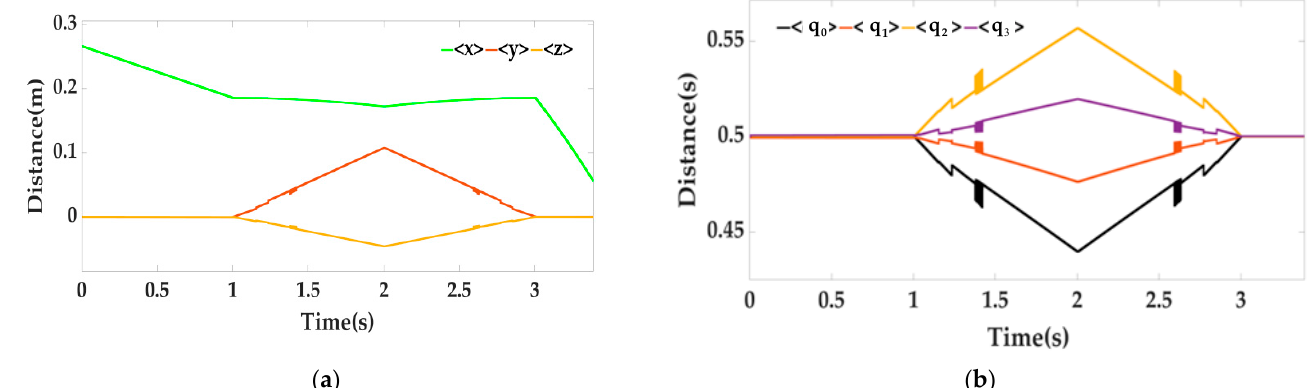
Figure 11. Six-dimensional posture graph, where ( a ) is the distance information graph and ( b ) is the quaternion graph.